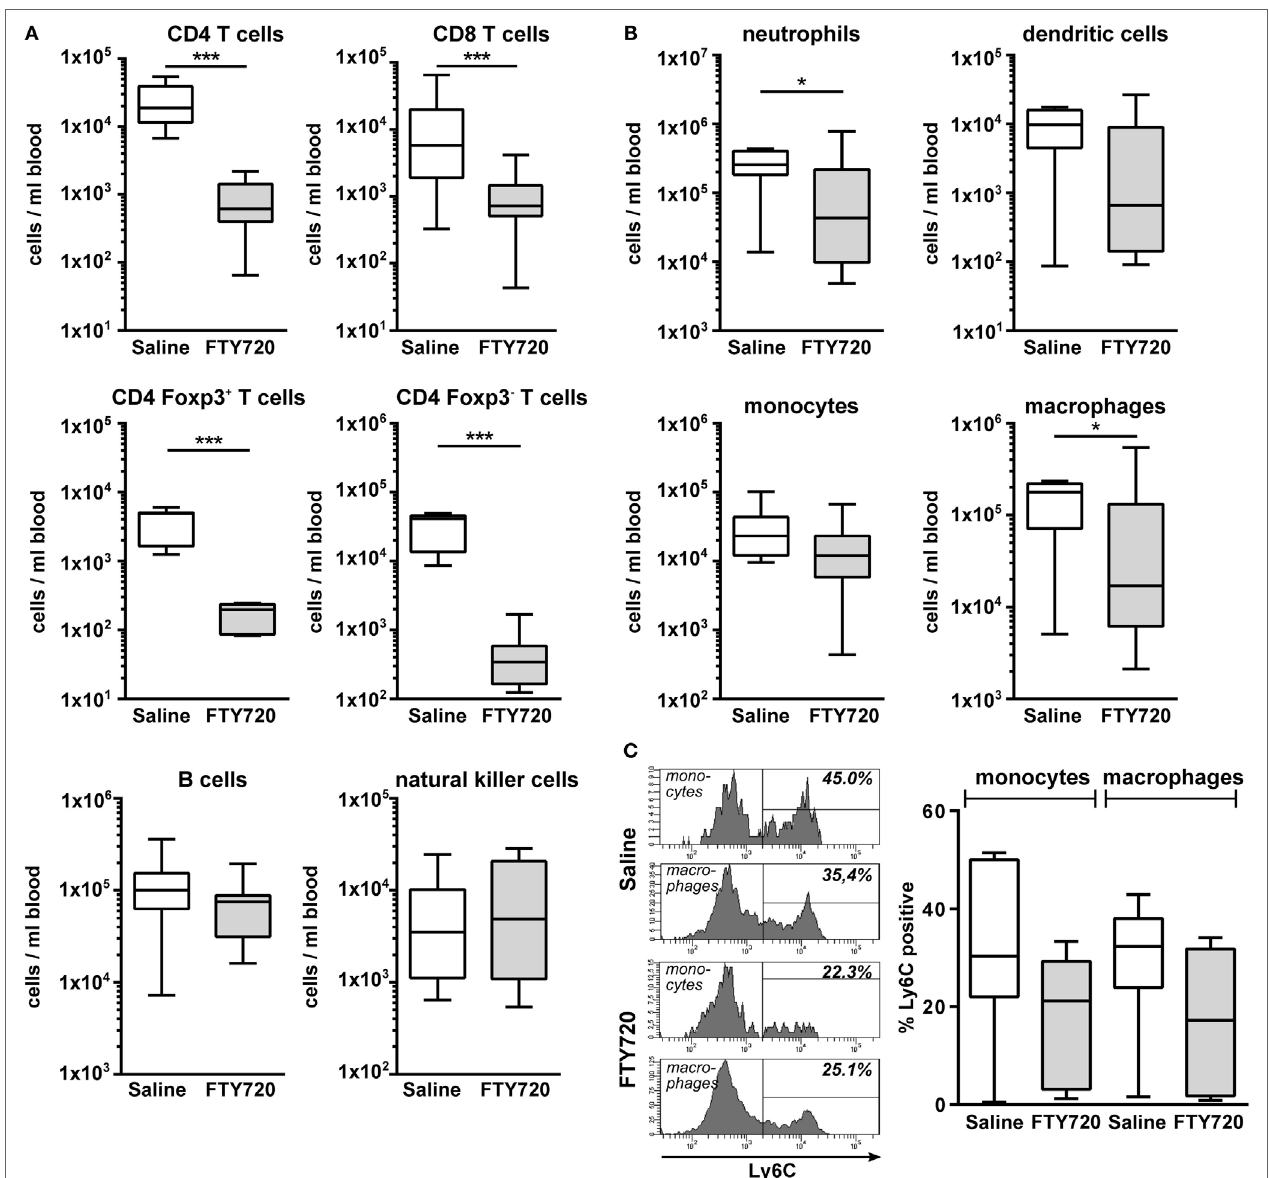
FigUre 6 | FTY720 treatment results in reduced peripheral T cell, neutrophil, and macrophage counts in neonatal HI-injured mice. Immune cell subset analysis in the peripheral blood was performed in P16 mice that were exposed to HI followed by a single intraperitoneal injection of 1 mg/kg FTY720 or 0.9% NaCl (saline) on P9. Different immune cell subsets were identified according to the gating strategy provided in Figure S1 in Supplementary Material. Briefly, viable peripheral leukocytes were identified as CD45 + FVD (fixable viability dye) − cells and further subdivided into B lymphocytes (CD19 + ), natural killer cells (NK1.1 + ), CD4 T cells (CD19 − , NK1.1 − , CD3 + , CD4 + ), CD8 T cells (CD19 − , NK1.1 − , CD3 + , CD8 + ), and regulatory T cells (CD3 + , CD4 + , Foxp3 + ) T cells (a) . For analysis of myeloid subsets viable leukocytes were gated for lymphocyte-depleted cells (CD3 − , NK1.1 − , B220 − ) and further subdivided into monocytes (CD115 + , Ly6G − ) and neutrophils (CD115 − , Ly6G + ). Remaining cells were gated by CD11b and CD11c to distinguish dendritic cells (Ly6G − , CD115 − , CD11c high ) and macrophages (Ly6G − , CD115 − , CD11c − , CD11b + ) (B) . Absolute lymphocyte (a) and myeloid (B) cell counts were quantified. For monocytes and macrophages, the proportion of inflammatory cells was quantified based on their Ly6C expression (c) . The amount of circulating T cells and of neutrophils and macrophages is significantly reduced in FTY720-treated HI mice, while the number of B, natural killer, and dendritic cells remained unchanged. n = 7–19/group unpaired t -test for Foxp3 + and Foxp3 − CD4 T cells in (a) and Ly6C + cells in (c) , remaining: Mann–Whitney